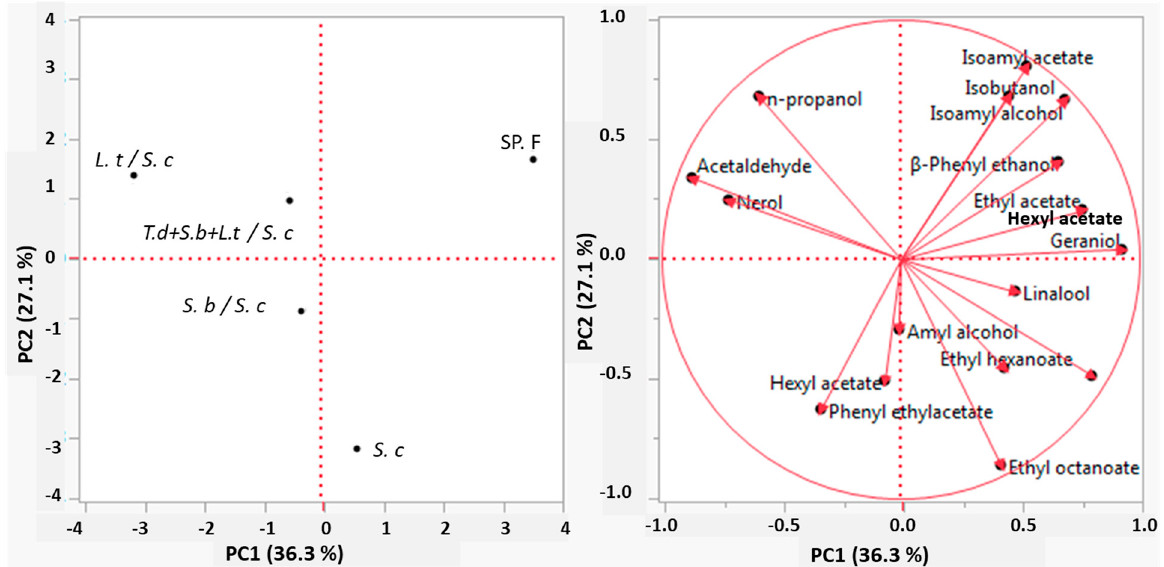
Figure 2. Principal component analysis based on the data regarding the main volatile compounds of wines obtained by S. cerevisiae ( S. c ); S. bombicola/S. cerevisiae ( S. b/S. c ); L. thermotolerans/S. cerevisiae ( L. t/S. c ); T. delbrueckii—S. bombicola—L. thermotolerans/S. cerevisiae ( T. d + S. b + L. t/S. c ); and spontaneous fermentation (SP.F).